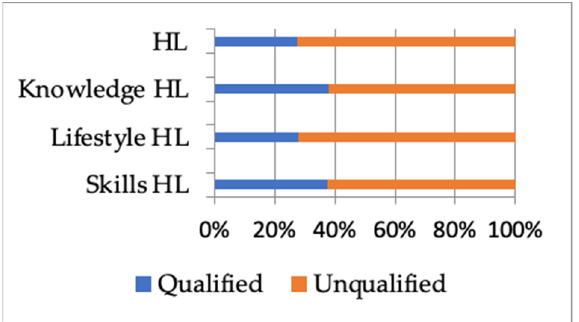
Figure 1. Levels of health literacy and the three dimensions of knowledge, lifestyle, and skills health literacy. (HL = health literacy). Table 1. General characteristics of participants qualified in health literacy, knowledge HL, lifestyle HL, and skills HL.